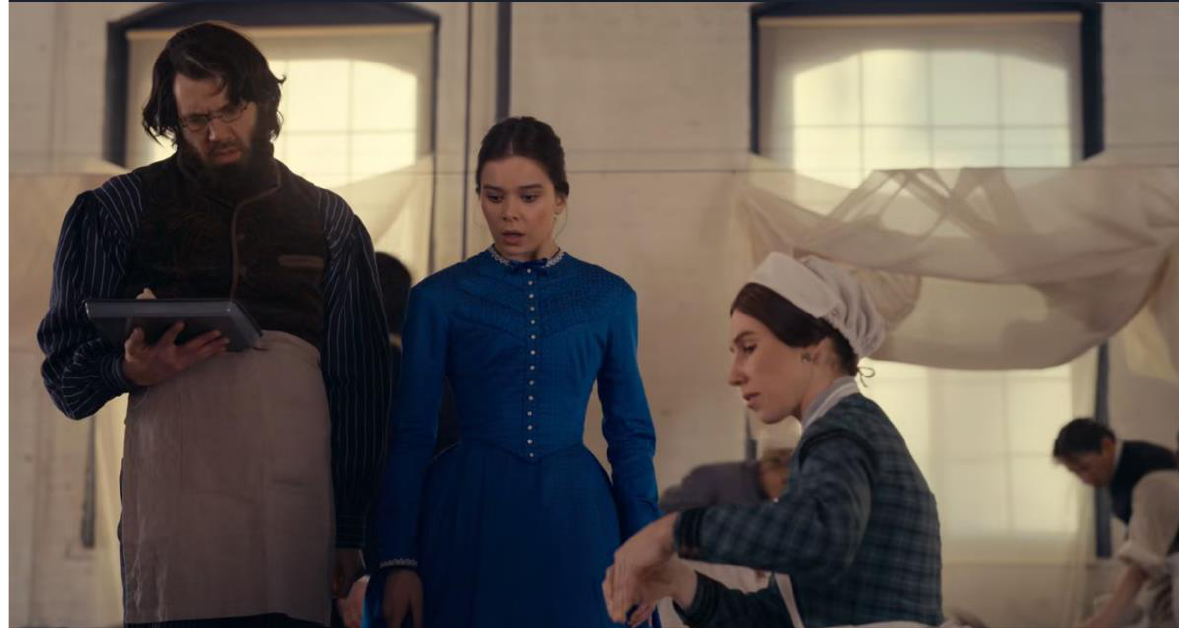
Figure 4. Emily meets her literary hero Walt Whitman and her previous acquaintance Louisa May Alcott in a New York City field hospital. Neither of her fellow writers’ approaches to artistic inspi- ration and suffering satisfies her questions about art in times of crisis and war.